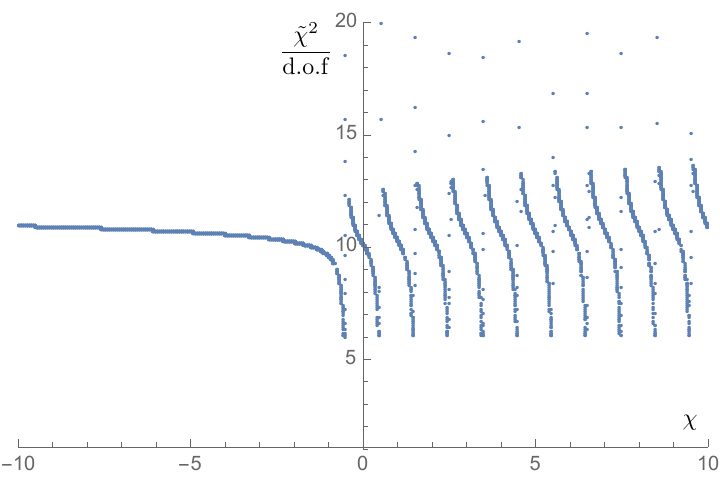
Figure 8 . A map of the minimum value of ~ (cid:31) 2 (cid:12)xing (cid:11) 0 = 0 : 25 GeV (cid:0) 2 , for each value of (cid:31) g